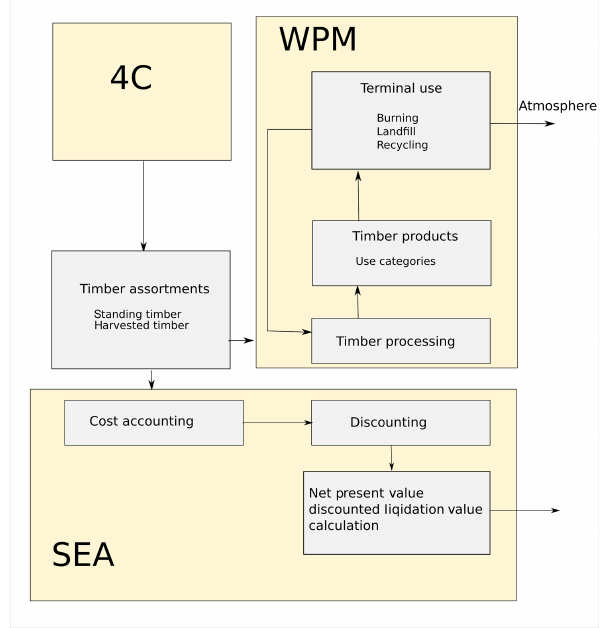
Figure 2. Model framework 4C (as presented in Fig. 1) coupled with the wood product model (WPM) and socio-economic analysis tool (SEA) (Eggers, 2002; Fürstenau et al.,